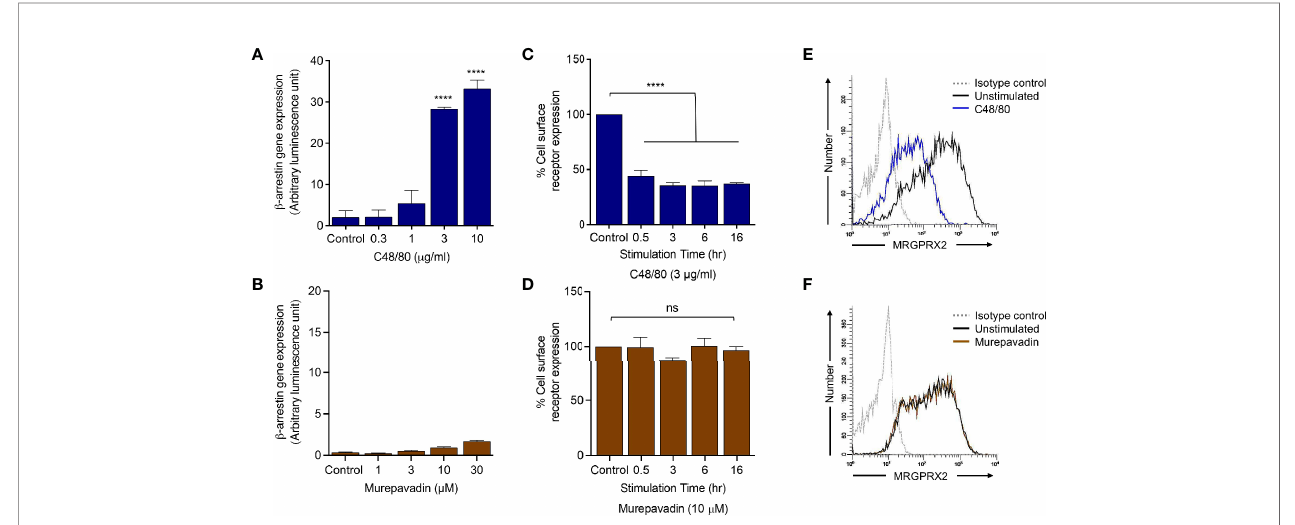
FIGURE 4 | Murepavadin does not promote b -arrestin recruitment following MRGPRX2 activation. (A, B) HTLA-MRGPRX2 cells were exposed to indicated concentrations of C48/80 or murepavadin for 16 h. Medium was removed and Bright-Glo solution (100 µL) was added into each well (96-well plate) and b -arrestin gene expression (in relative luminescence unit) was measured. (C, D) HTLA-MRGPRX2 cells were exposed to MRGPRX2 ligand (C48/80 or murepavadin, 16 h) and cell surface receptor expression of MRGPRX2 was con fi rmed using fl ow cytometry and quanti fi ed using a mean fl uorescent intensity (MFI) in comparison to the untreated control. (E, F) Representative histograms of MRGPRX2 cell surface receptor expression of HTLA-MRGPRX2 cells. Statistical signi fi cance was determined by one-way ANOVA with Dunnett ’ s multiple comparisons at a value **** p < 0.0001 and ns denotes “ not signi fi cant ” .